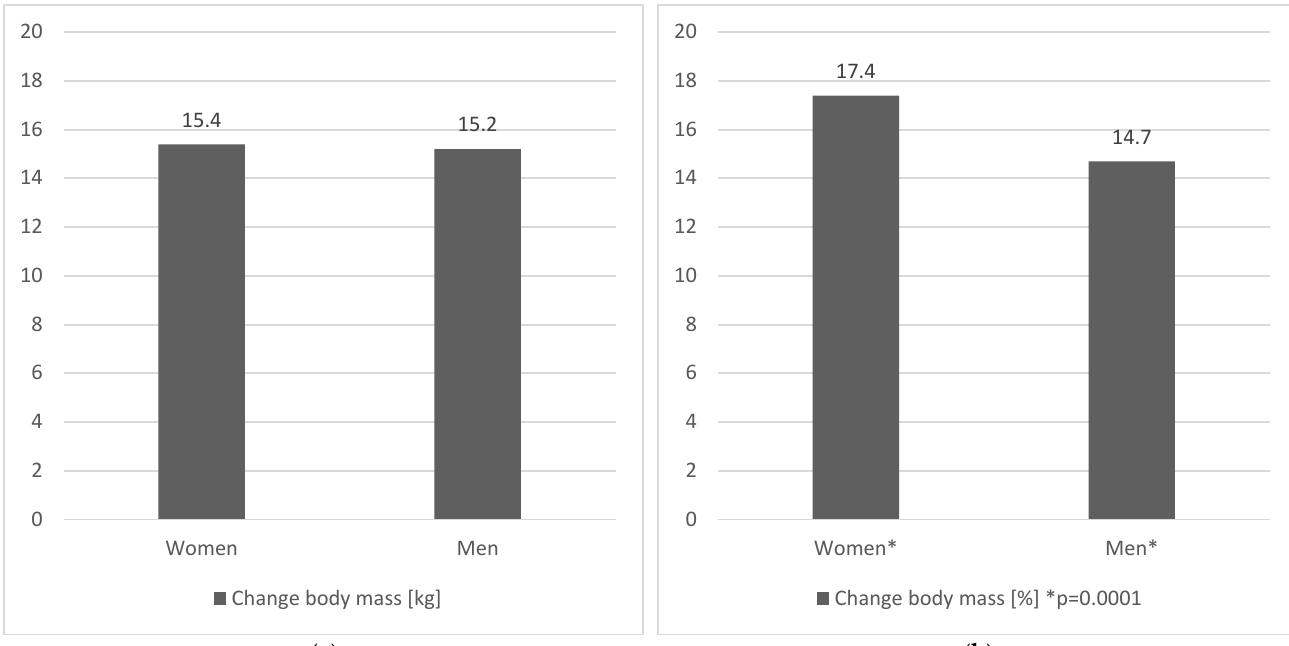
Figure 1. ( a ). Change in body weight (average) in men and women after 12 months expressed in absolute value [kg]. ( b ) Change in body weight (average) in men and women after 12 months expressed in relative value [%]. * Mann – Whitney U Test.